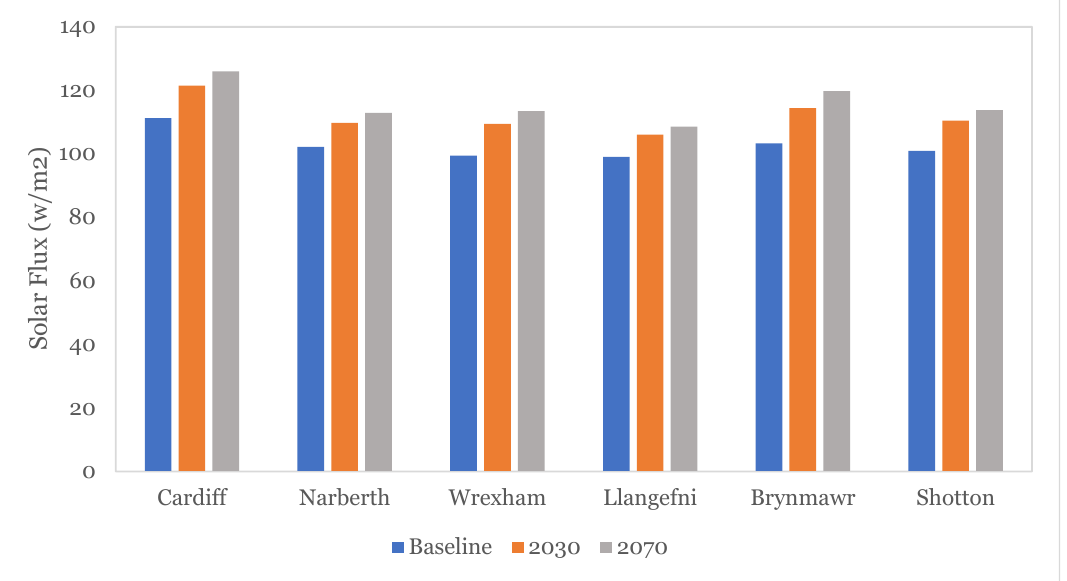
Figure 3. Daily average solar flux averaged over the study period for six locations throughout Wales for baseline, 2030 and 2070.